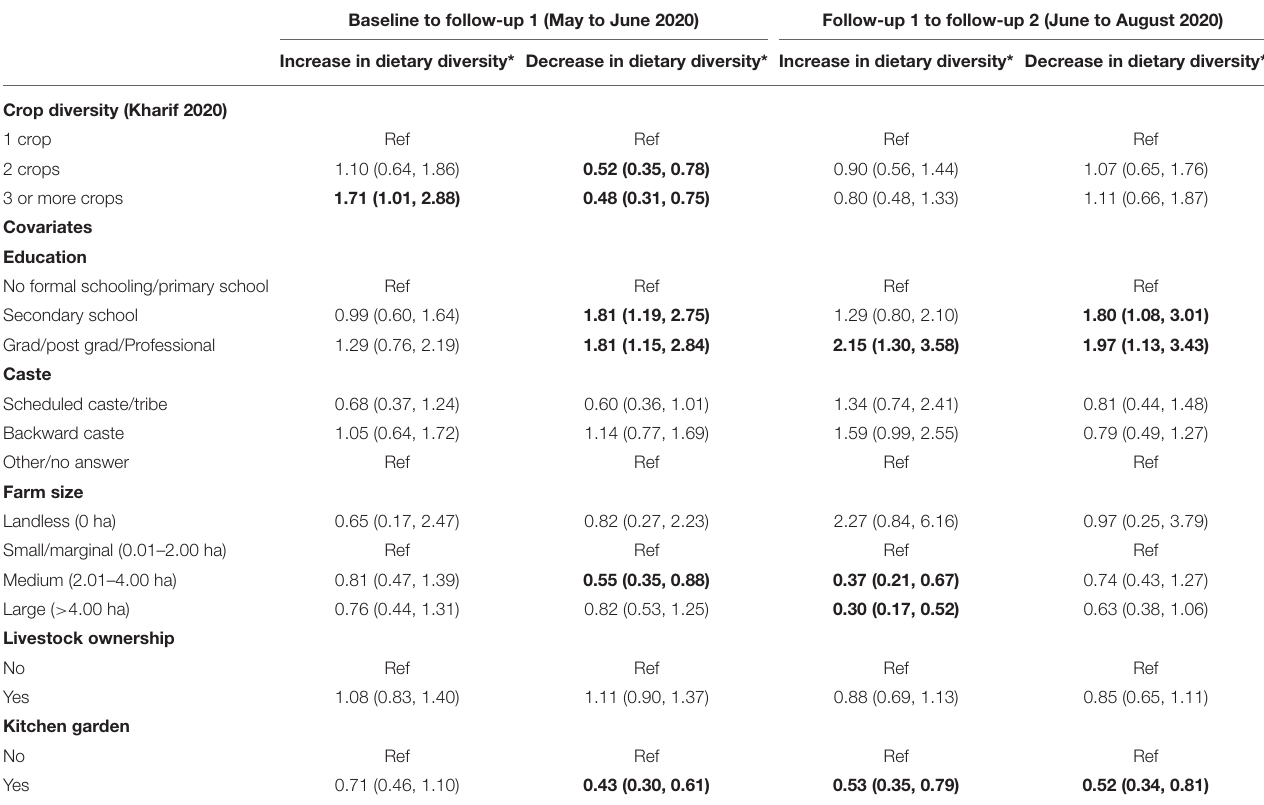
TABLE 3 | Association between crop diversity and dietary diversity in participants from agricultural households across 12 states in India during the COVID-19 pandemic ( n =